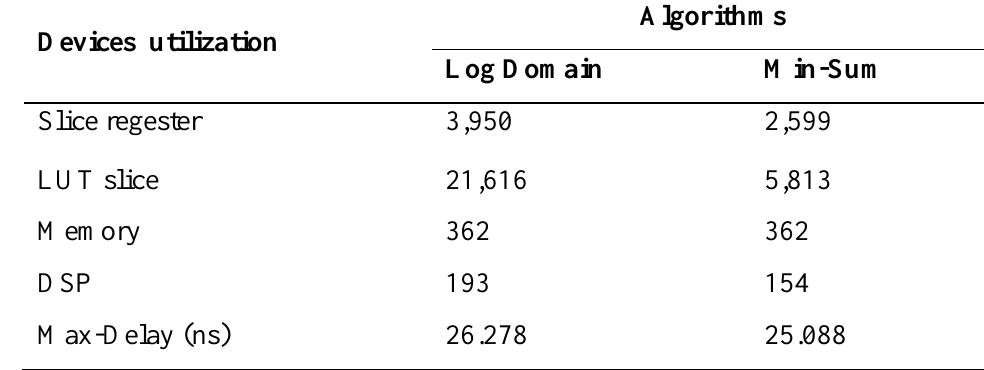
Table 2. Comparison of resource